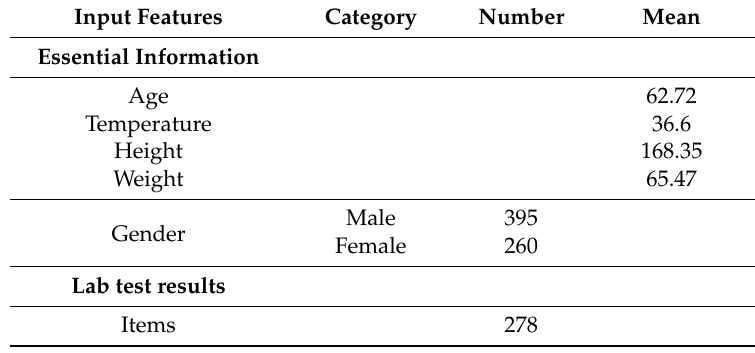
Table 2. The Statistics of Features.